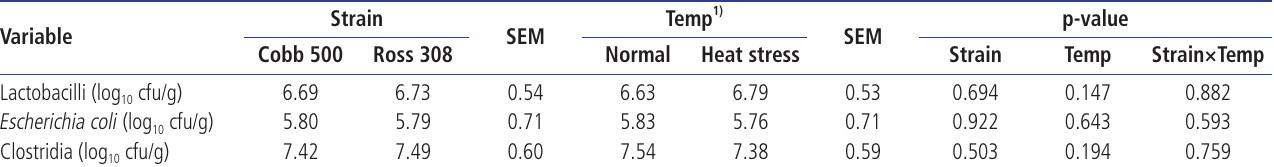
Table 6. Effects of strain and temperature on caecal Lactobacilli, Escherichia coli, and Clostridia populations in broiler chickens at 35 days of age Strain Temp 1) Variable SEM SEM Cobb 500 Ross 308 Normal Heat stress Strain Temp